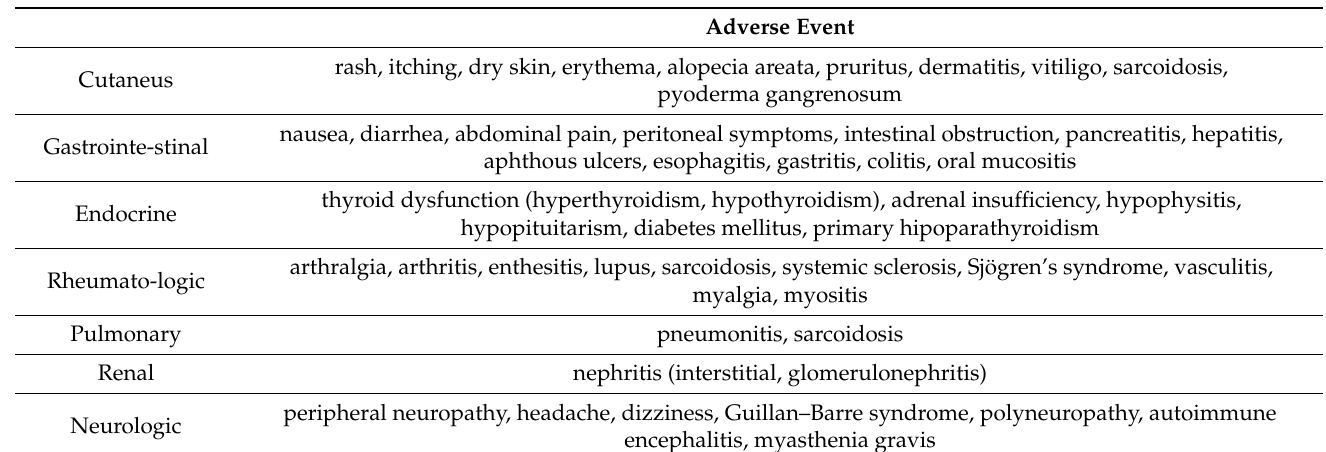
Table 3. Adverse events with immune checkpoint